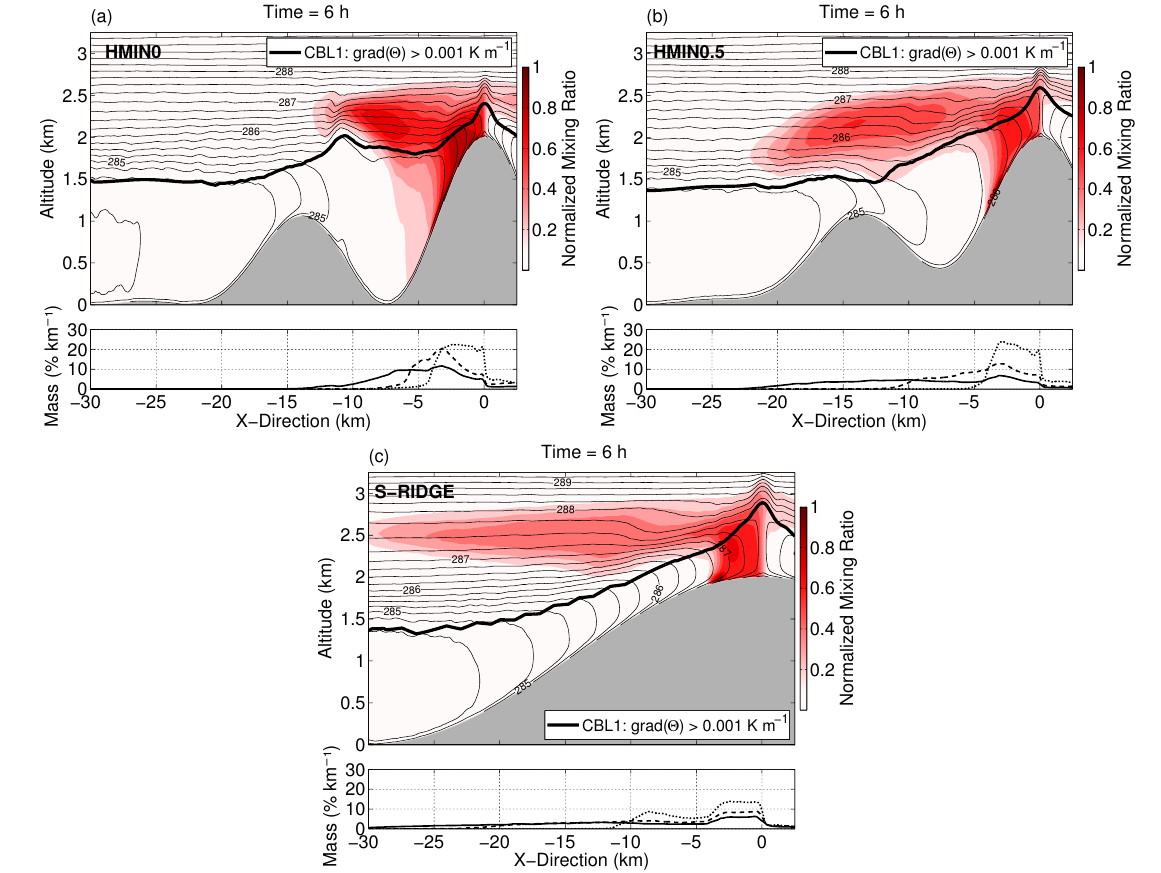
Figure 10. As in Fig. 8 for the (a) HMIN0, (b) HMIN0.5, and (c) S-RIDGE simulation, but a tracer has been constantly emitted within the region between − 4 km ≤ x ≤ −